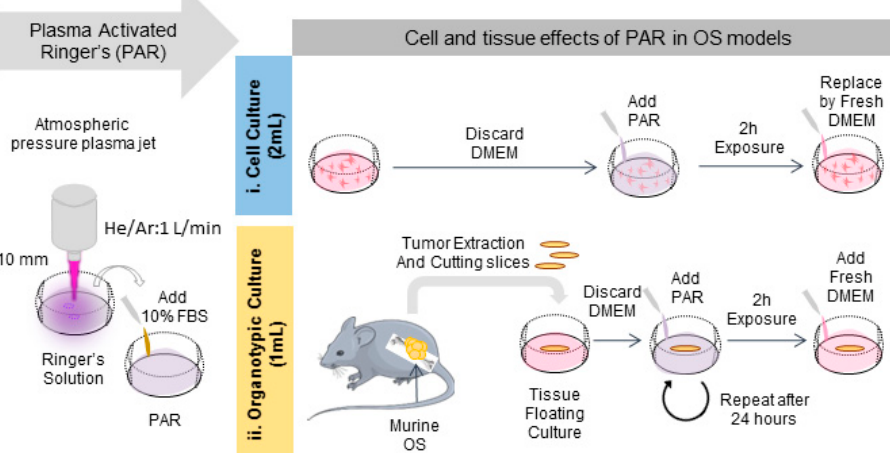
Figure 4. Protocol followed for the generation of PAR and the treatment of cell and organotypic cultures. Briefly, PAR was obtained by treatment of Ringer’s saline at different times followed by adding 10% FBS. For cell cultures ( i ), cells were placed with 2 mL-treated PAR and incubated during 2 h; after that PAR was replaced by fresh medium. For organotypic cultures ( ii ), murine OS tumors were cut in slices and placed in floating culture; then samples were placed with 1 mL-treated PAR during 2 h and after that, PAR was diluted at 25% in fresh medium. In this case, treatment was repeated after 24 h.